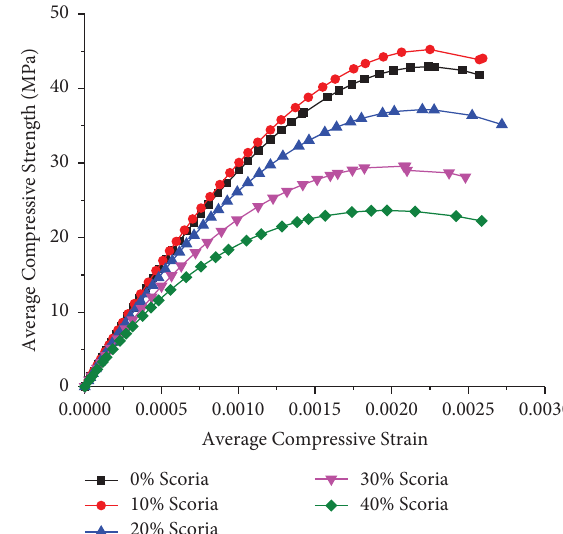
Figure 11: Stress-strain curve for 90days compressive strength